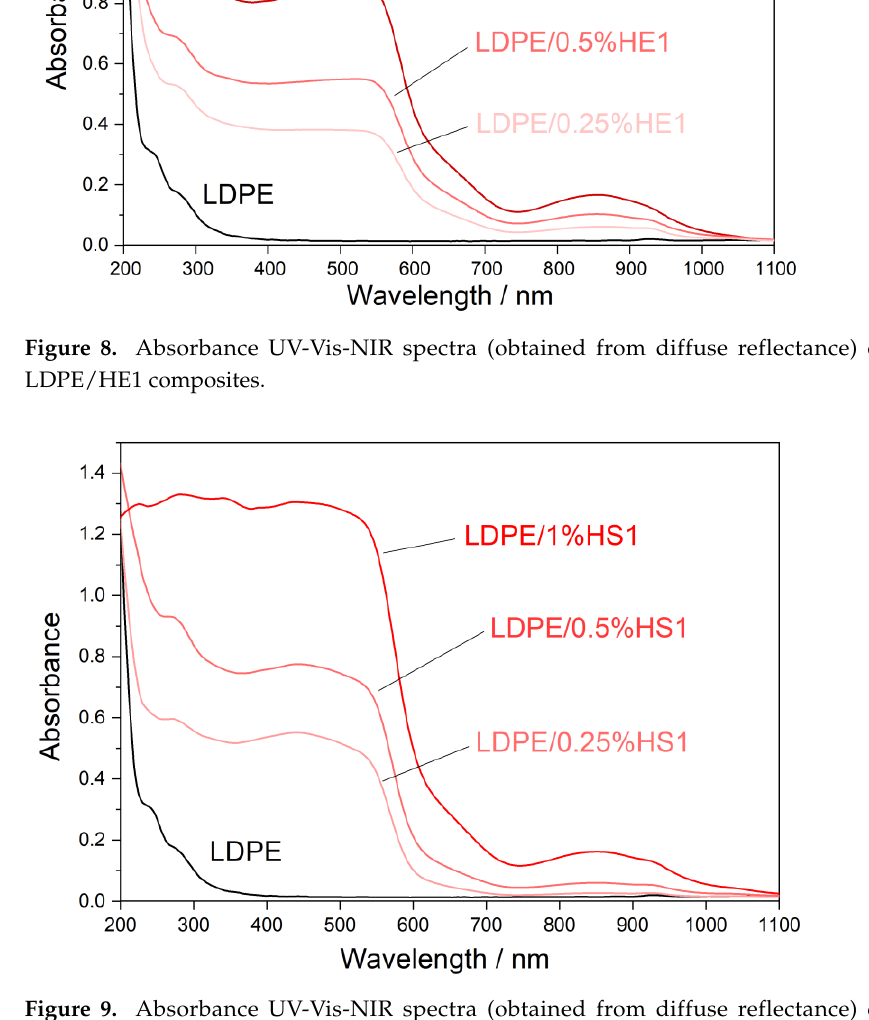
Figure 9. Absorbance UV-Vis-NIR spectra (obtained from diffuse reflectance) of LDPE and LDPE/HS1 composites.